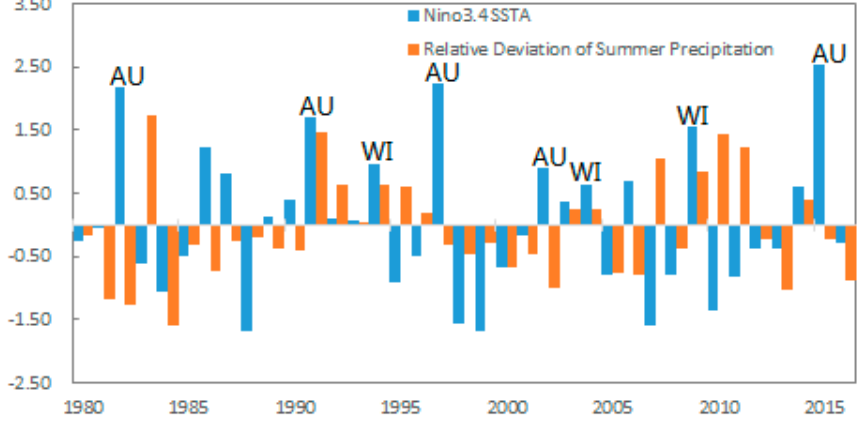
Figure 3. Temporal evolution of the Niño 3.4 SST anomaly (blue; units: °C) and normalized austral summer rainfall (orange) over southeastern Australia in DJF 1980–2017.